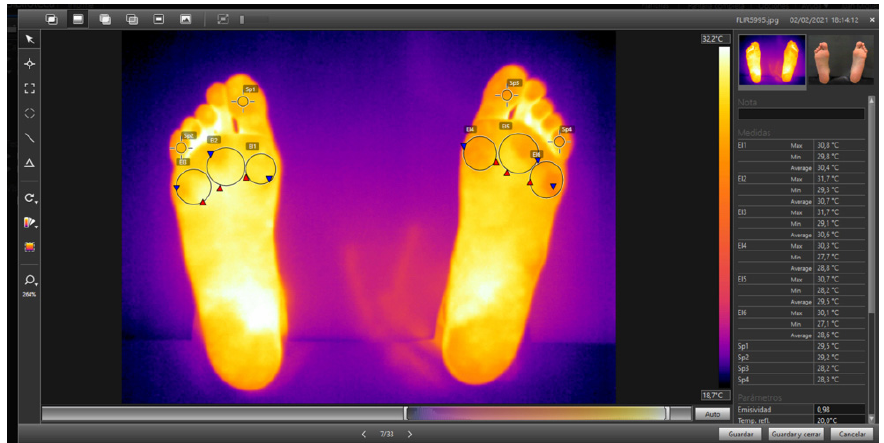
Figure 3. Thermographic image. Detail of the black background (top, right), with the anatomical zones analyzed. The software yields the upper, lower, and mean temperatures for each zone.